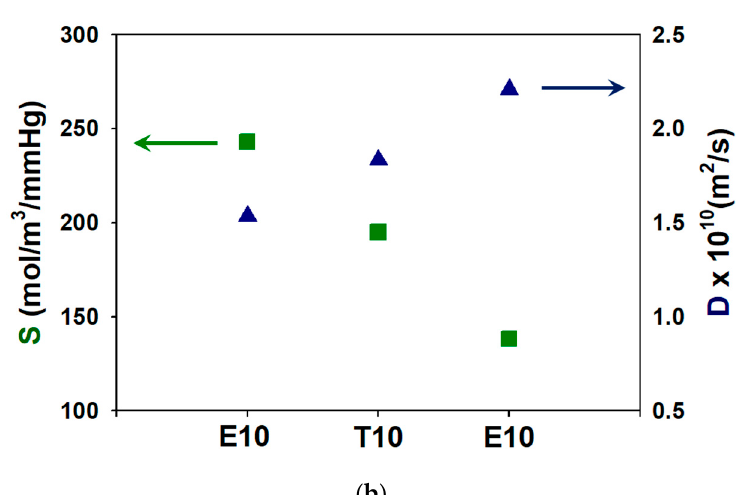
Figure 6. Effect of crosslinkers on ( a ) water permeabilities and ( b ) sorption and diffusion coefficients of crosslinked PAMPS.